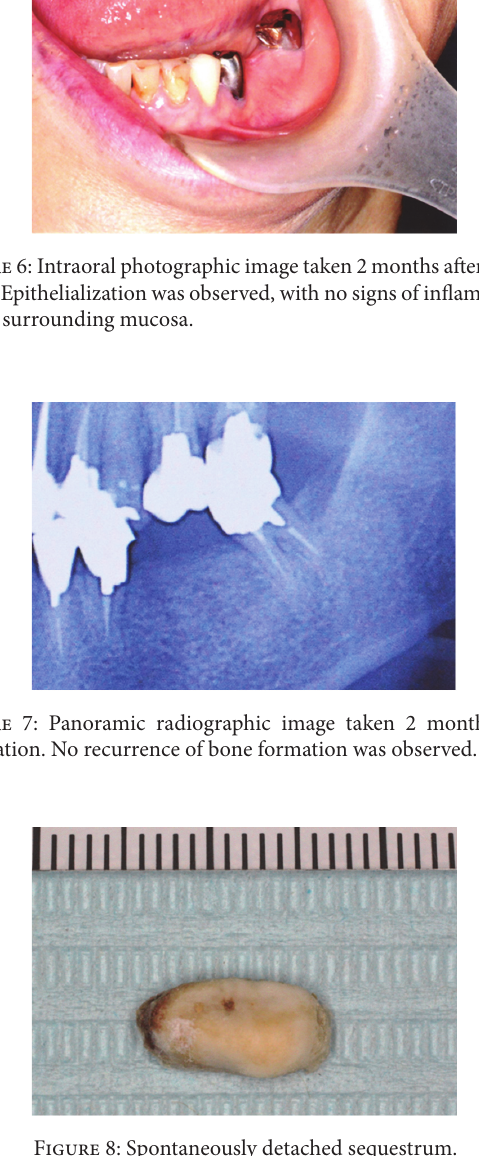
Figure 8: Spontaneously detached